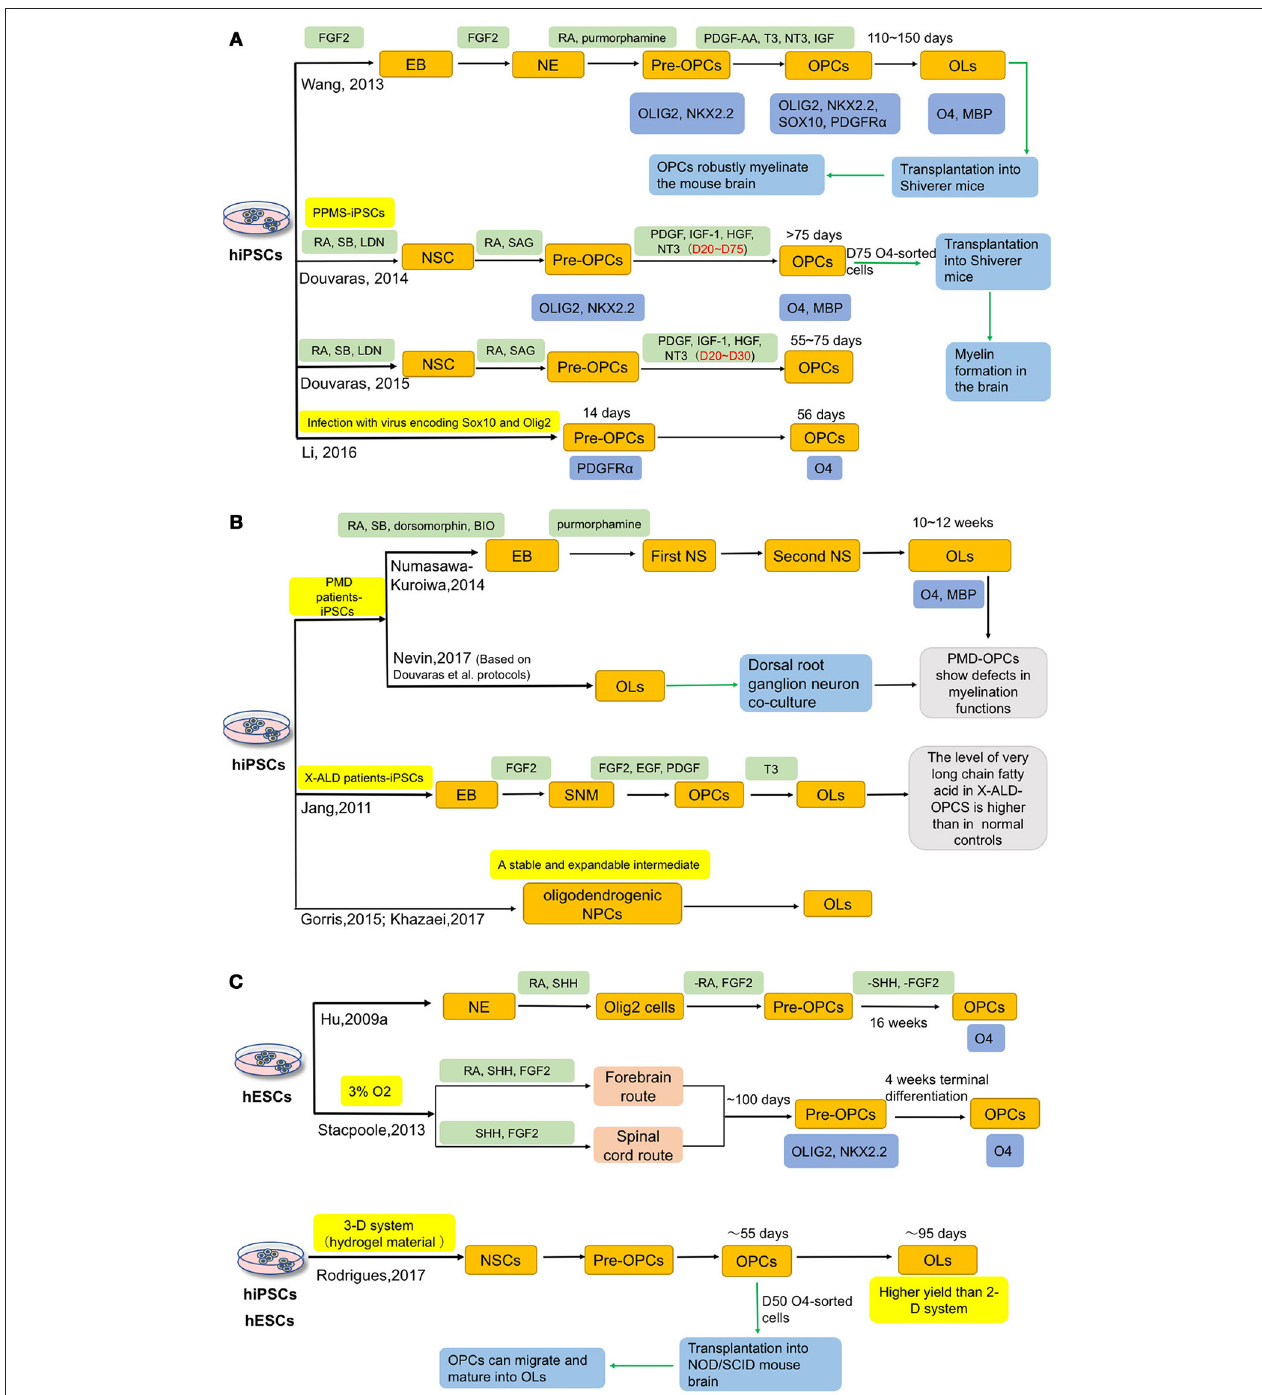
FIGURE 3 | Current approaches for deriving OLs from hiPSCs. Oligodendrocytes can be induced from both hESCs and hiPSCs. (A) Wang, Douvaras and Li et al. induced hiPSCs, including MS patient-iPSCs, intoOPCs, respectively. Besides, they accelerated the process by adding different small molecules or infecting virus. (B) In order to better understand the role of OPCs in related diseases, several groups have differentiated patient-iPSCs into OPCs, such as Pelizaeus-Merzbacher disease (PMD), X-linked adrenoleukodystrophy (X-ALD). Additionally, generation of a stable and expandable intermediate, oligodendrogenic NPCs, could provide a convenience advantage for potential clinical applications. (C) In 2009, Hu et al. used SHH as a key factor to induce OLs from hESCs. And Stacpoole et al. shortened the differentiation period to 120 days by inducing OPCs in a low oxygen tension environment. Compared with the traditional 2-D culture system, Rodrigues et al. successfully generated hESCs and hiPSCs into OPCs in 3-D systems, which could get higher yields of OPCs and may also provide a platform to study the cell-cell interactions in vitro .